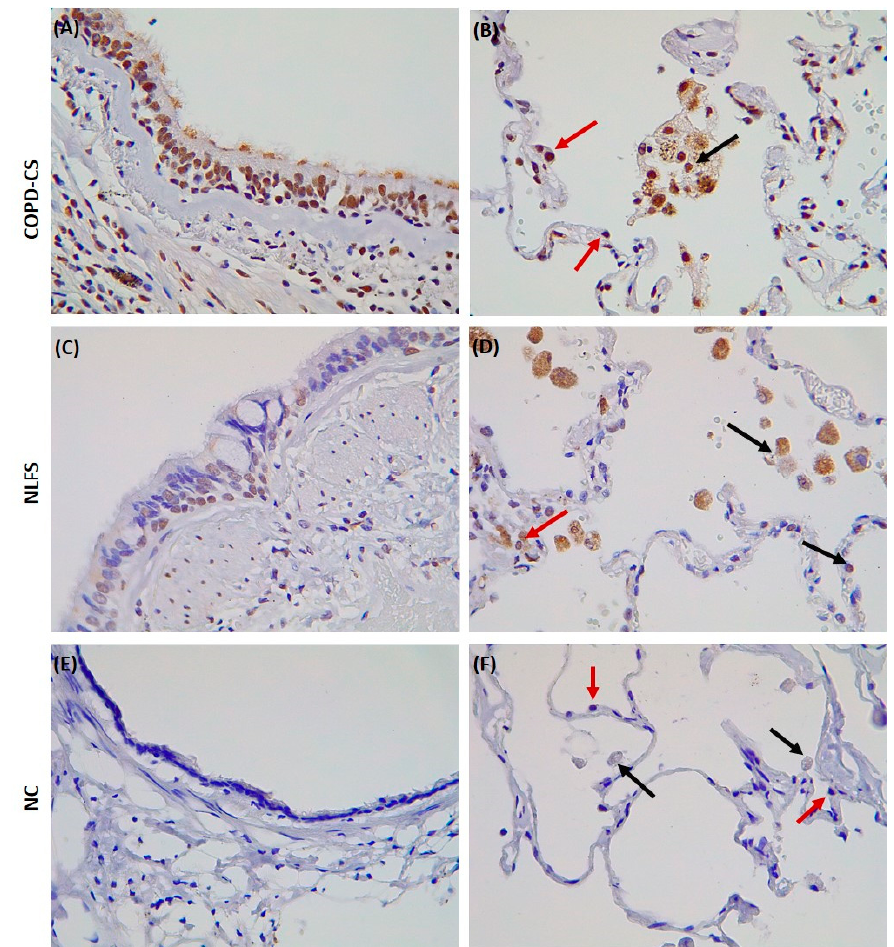
Figure 1. Surgically resected lung tissue stained for the angiotensin-converting enzyme-2 (ACE2) receptor. Current smoker with chronic obstructive pulmonary disease (COPD-CS), ( A ) showing positive staining in the small airway epithelium but also apical including cilia ( B ) red arrows indicating positive staining in type-2 pneumocytes and black arrows showing alveolar macrophages positive for the ACE2 receptor. Normal lung function smoker (NLFS), ( C ) and ( D ) showing similar pattern for COPD-CS although a little less staining is observed. Normal controls (NC), ( E ) and ( F ) no staining observed in any of the areas. This is the first immunohistochemical human lung evidence for ACE2 receptor expression in smokers and patients with COPD.